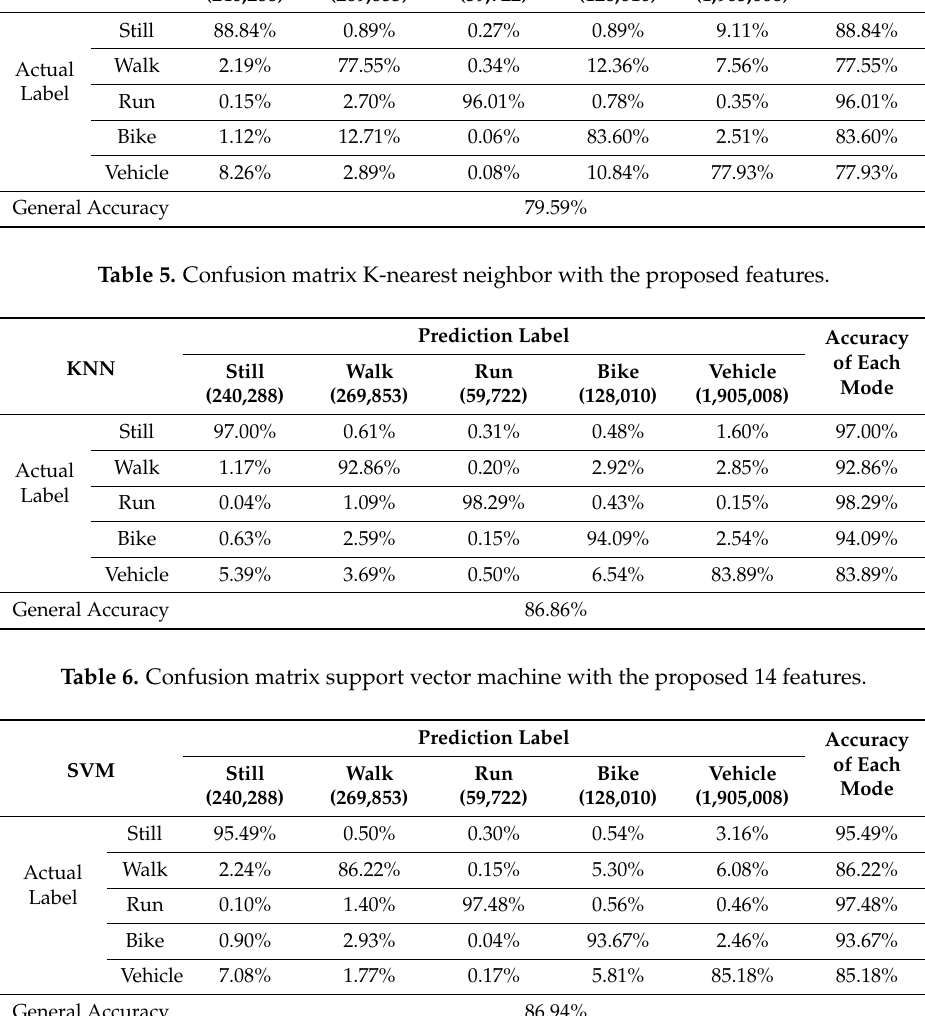
Table 5. Confusion matrix K-nearest neighbor with the proposed features.